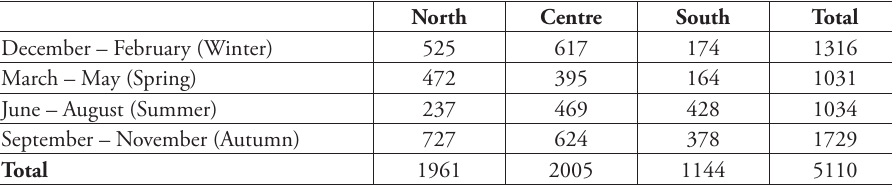
Table 2. Number of records per region and per three-month period, corresponding with the seasons of the year.